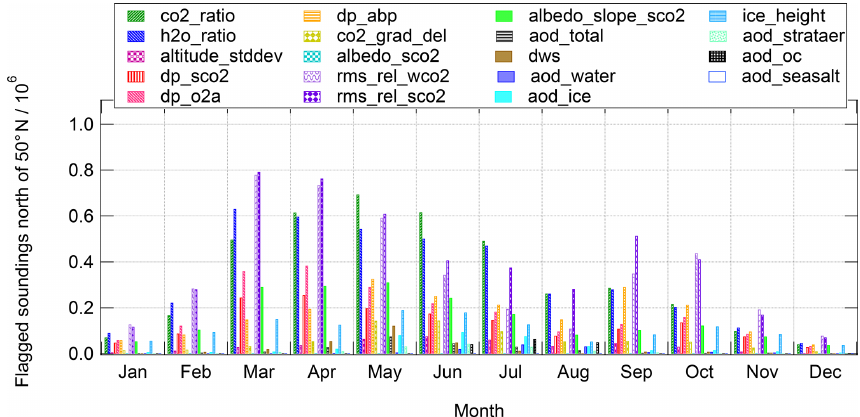
Figure 3. Total number of land soundings north of 50 ◦ N flagged bad by B9-quality filters in each